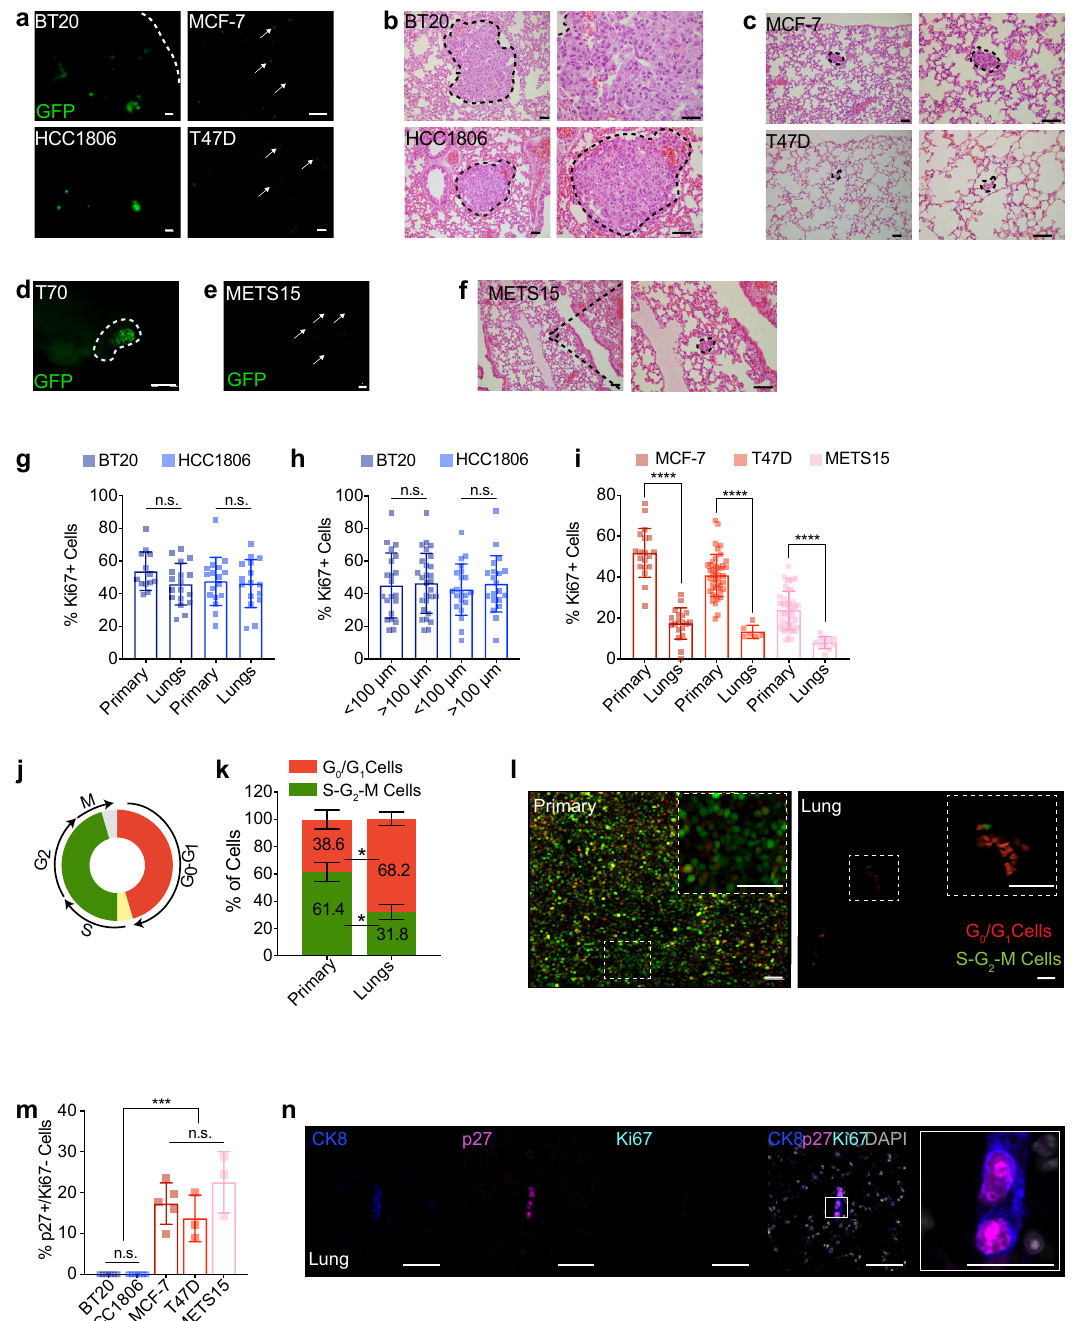
Fig.2|ER + metastaticlesionsaredormant.a Representative fl uorescencestereo micrographs of lungs from ≥ 3 mice with BT20, HCC1806, MCF-7, or T47D intra- ductal xenografts, arrows point to DTCs. Scale bar, 1mm. b , c Representative micrographsofH&Estainedlungsectionsfrom3micebearingBT20andHCC1806 ( b ) or MCF-7 and T47D ( c) intraductal xenografts. Scale bar, 50 µ m. d , e Repre- sentative fl uorescence stereo micrographs of the liver ( d ) and lungs ( e ) from ≥ 3 micebearingT70andMETS15MINDxenografts.Scalebars,1mm. f Representative micrographsofH&Estainedlungsectionsfrom3micebearingMETS15intraductal xenografts. Scale bars, 50 µ m. g Percentage of Ki67 + cells in matched primary and lung sections from mice 5 weeks after intraductal injection of BT20 and HCC1806 cells, n ≥ 14 sections. h Bar graph showing Ki67 index of BT20 and HCC1806 lung lesionsofdifferentsizes. i Ki67 + indexinmatchedprimarytumorandlungsections frommice5monthsafterintraductalinjectionofMCF-7,T47D,andMETS15cellsas indicated. In g and i each data point represents ≥ 1,000 and 100 cells analyzed,